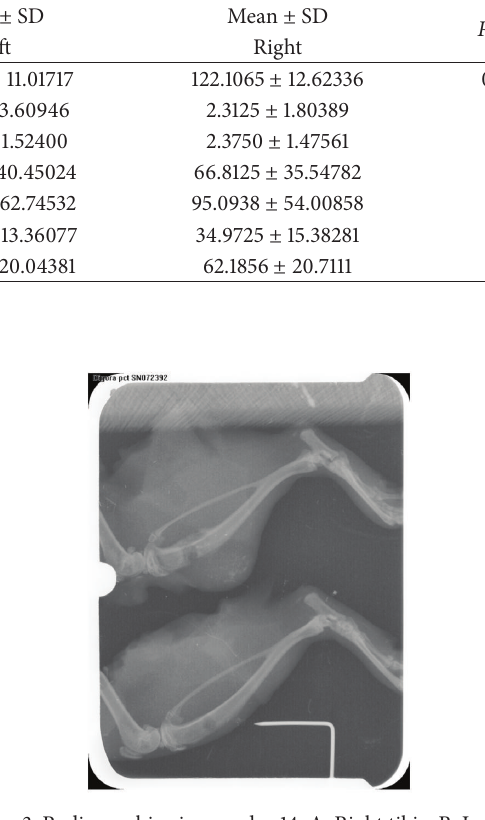
Figure 3: Radiographic view on day 14. A: Right tibia. B: Left